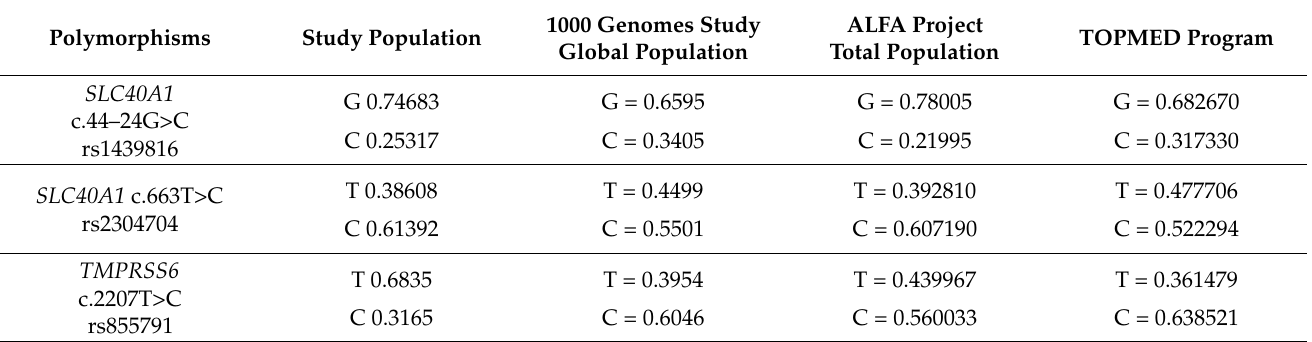
Table 4. The allelic frequencies of the analyzed SNPs in the studied population compared to those in the 1000 Genomes, ALFA, and TOPMED